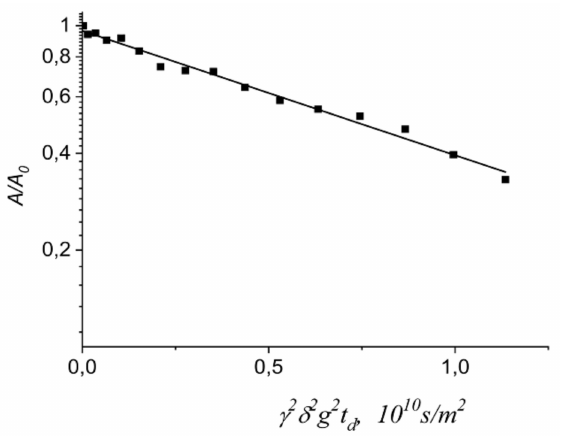
Figure 37. Diffusion decay of 23 Na nuclei in Nafion membrane Na + ionic form, RH = 95%, t = 20 ◦ C. Reprinted with permission from [109]. Copyright 2021 Elsevier.